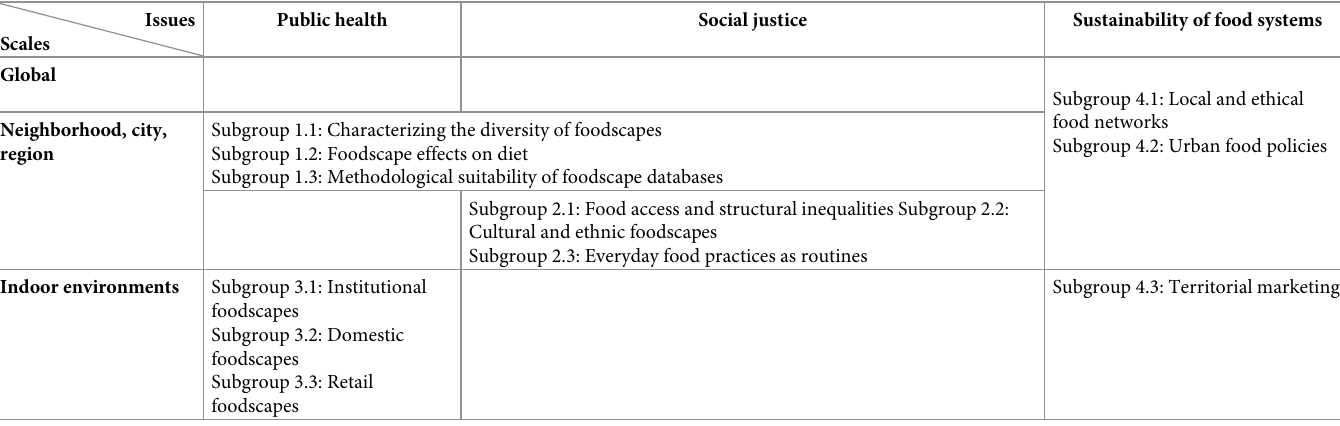
Table 2. Issues and scales covered by foodscape